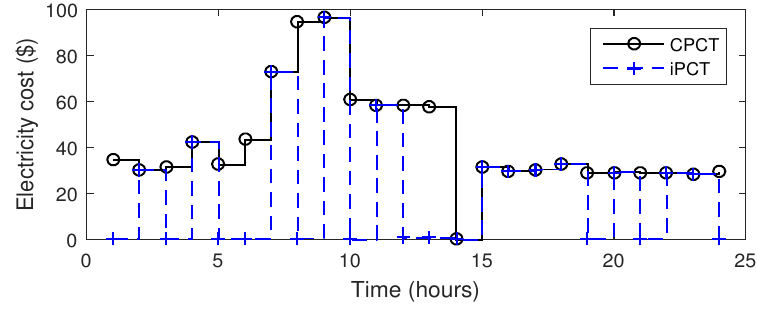
Figure 9. Energy consumption cost of